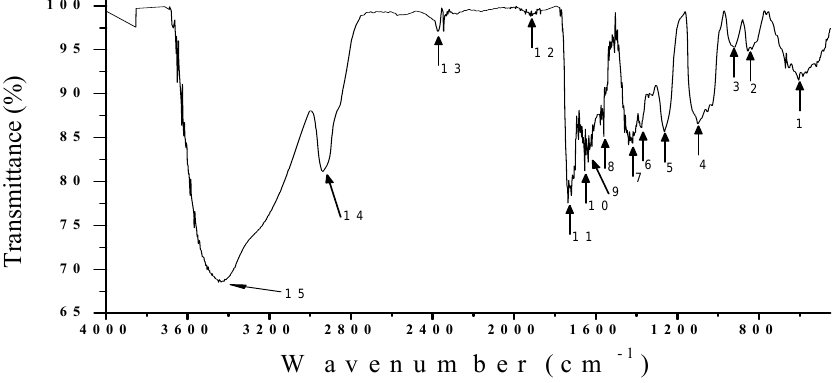
Figure 4. The vibrational behavior of the molecular structures that form the fermented extract nopal with the PVA through an IR